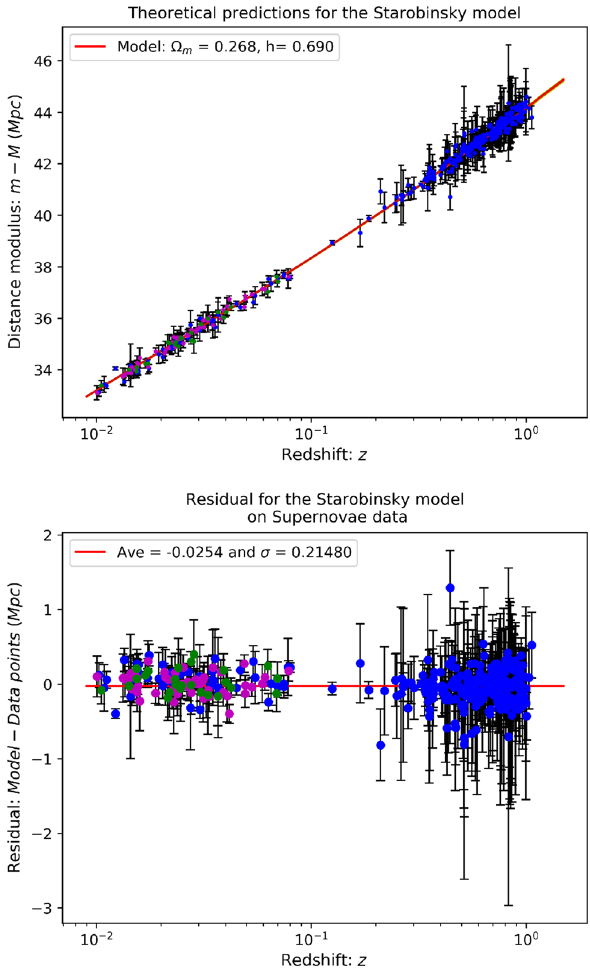
km (con- 0 . 5 s . Mpc 1 . 050 (uncon- 2 . 899